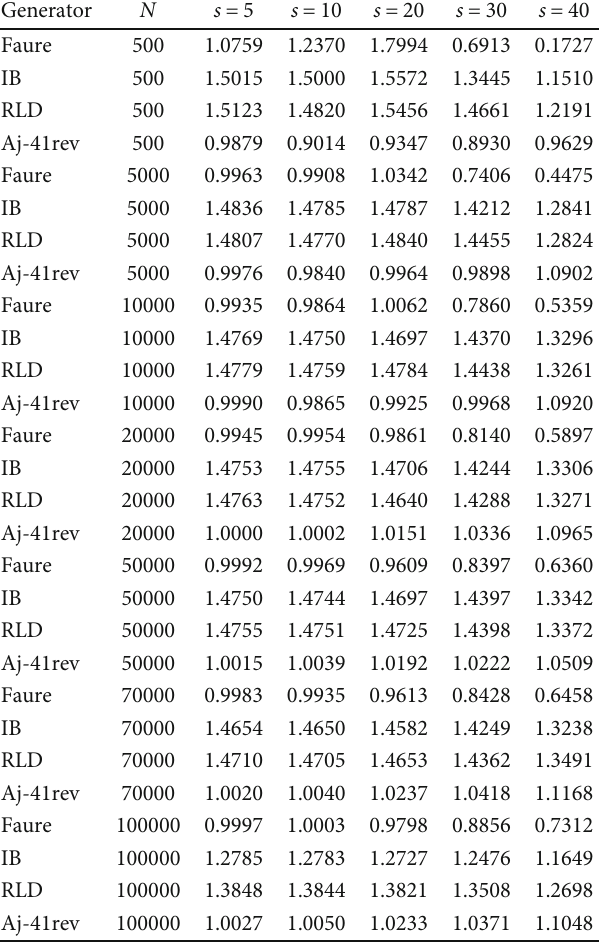
ð f Þ with a = i by using Faure 2 i